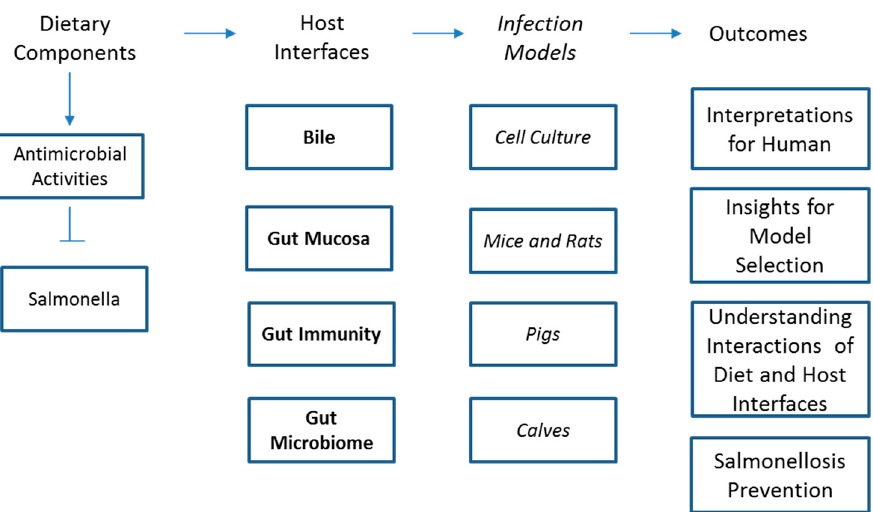
Figure 1. Relationships between dietary bioactive components and Salmonella infection. Dietary bioactive components such as fiber, amino acids, vitamins and minerals, fatty acids, and polyphenols improve the gut epithelium, microbiota, and immunity that may eventually lead to increased resistance to Salmonella infection.